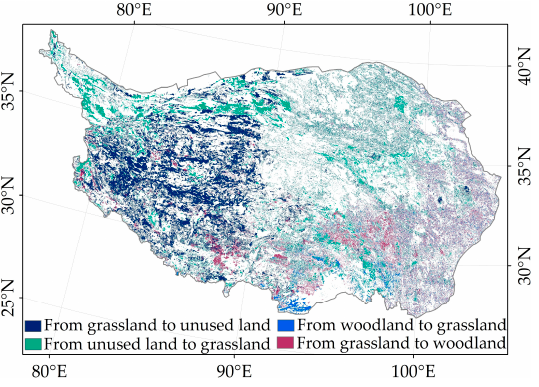
Figure 6. Land use and cover changes on the QTP: ( a ) 1980; ( b ) 2018.